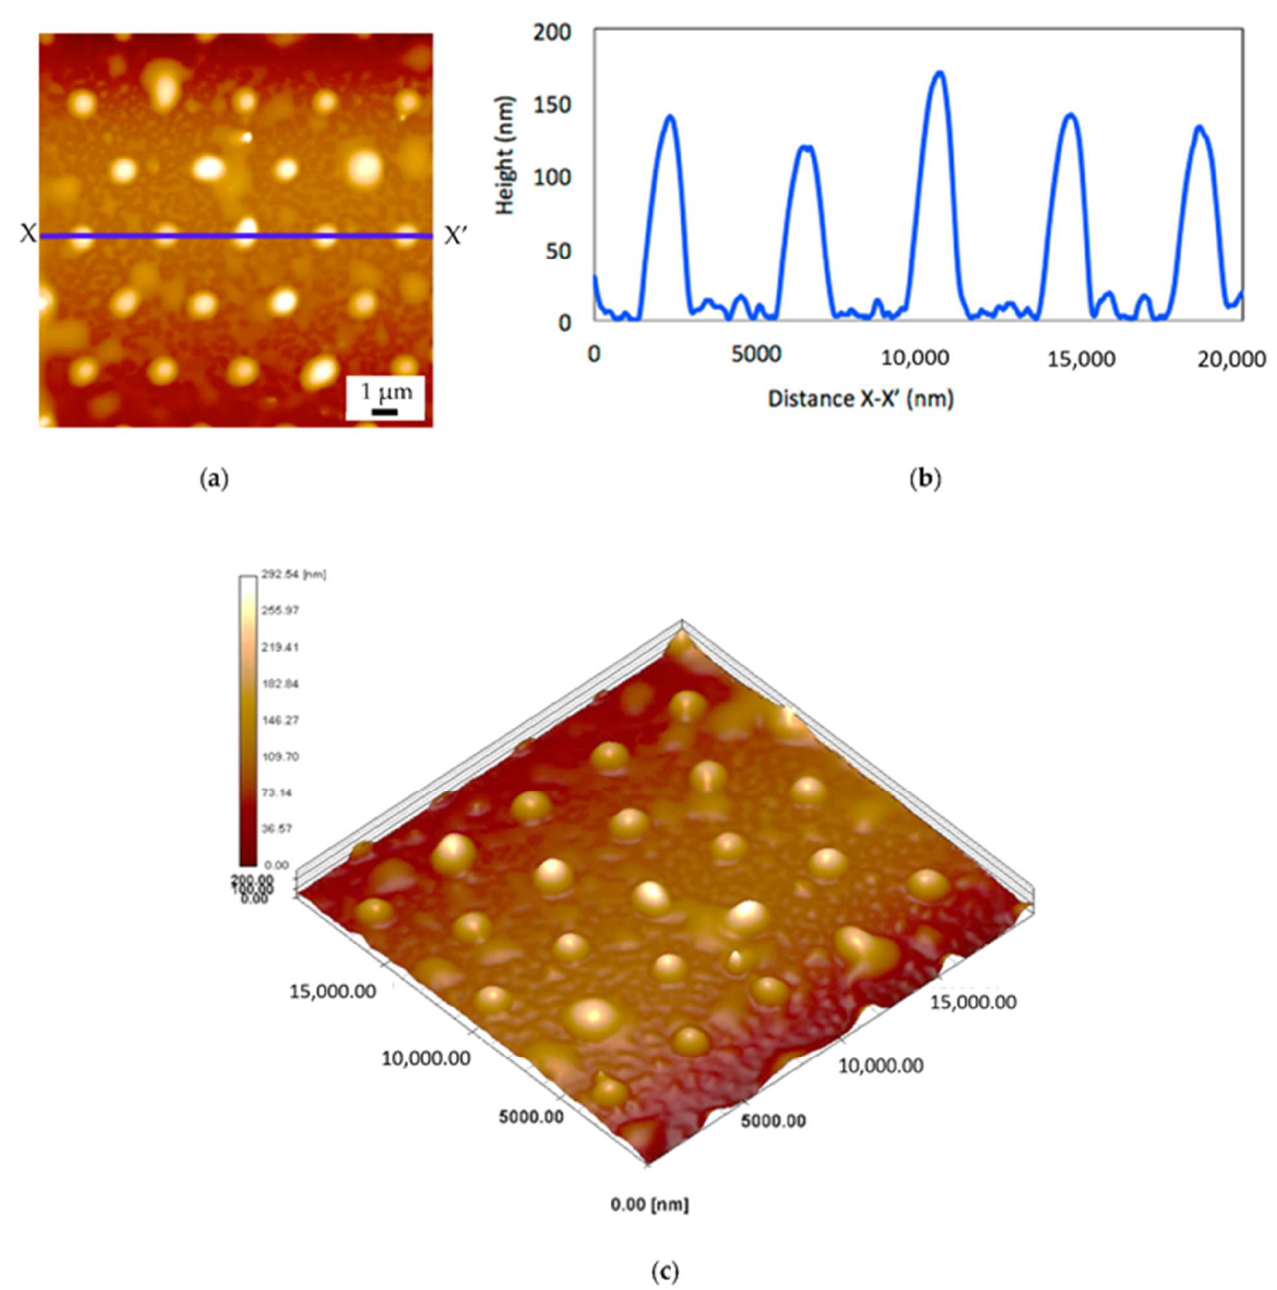
Figure 3. ( a ) The topography image, ( b ) the profiles, and ( c ) the 3-dimensional image topography of a gold film coated onto the methanol stamped glass plate via a soft stamping process.